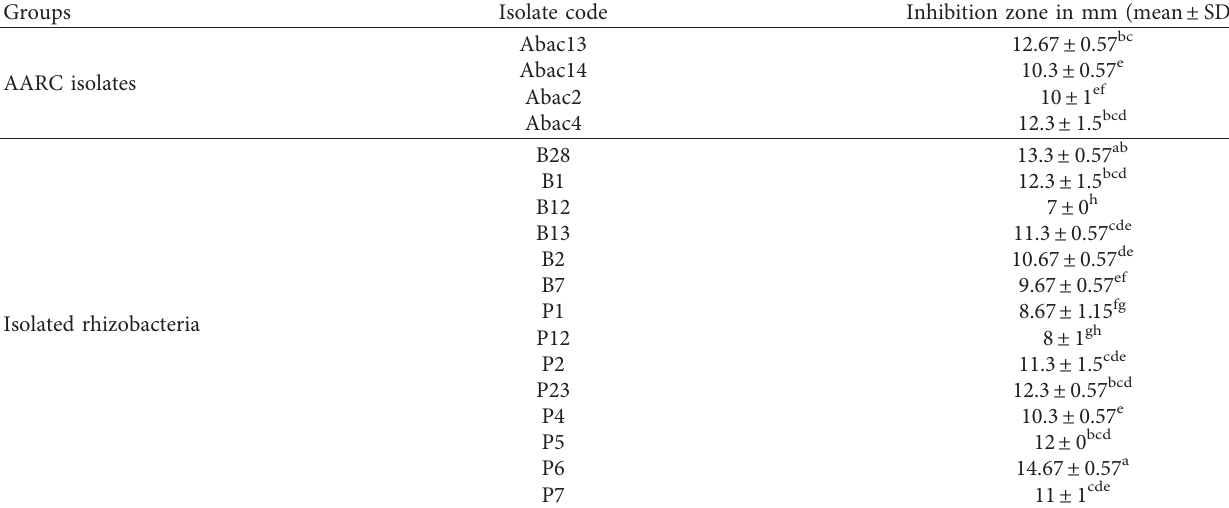
Table 2: Mean radial zone of inhibition produced by B. subtilis (reference isolates) and rhizosphere bacteria ( Bacillus and Pseudomonas spp.) against R. solanacearum, n � 3.